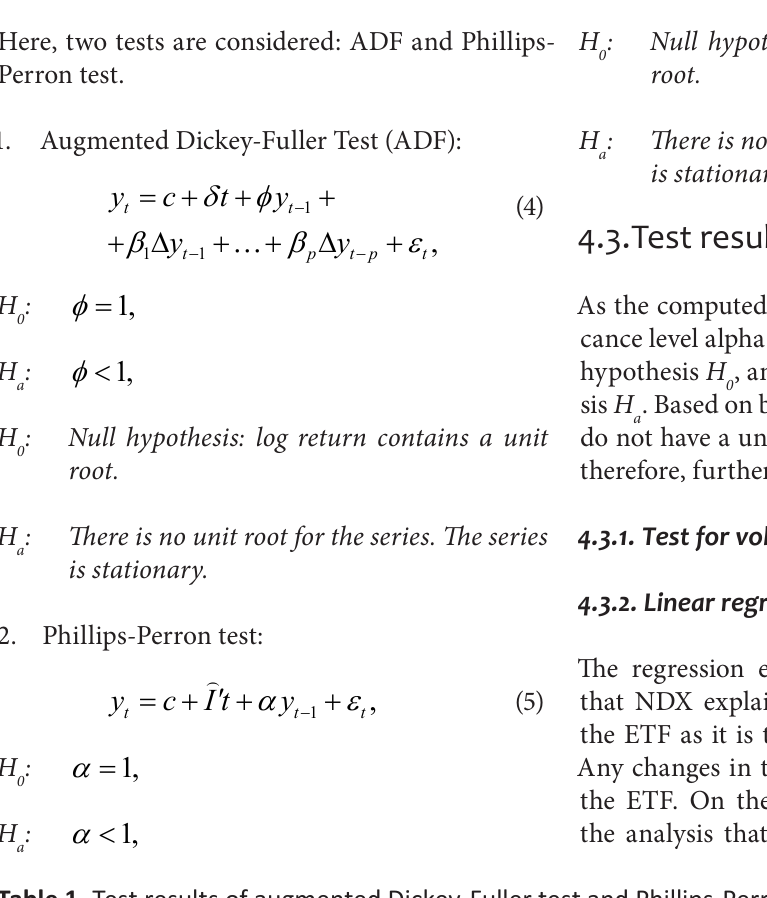
Table 1. Test results of augmented Dickey-Fuller test and Phillips-Perron test